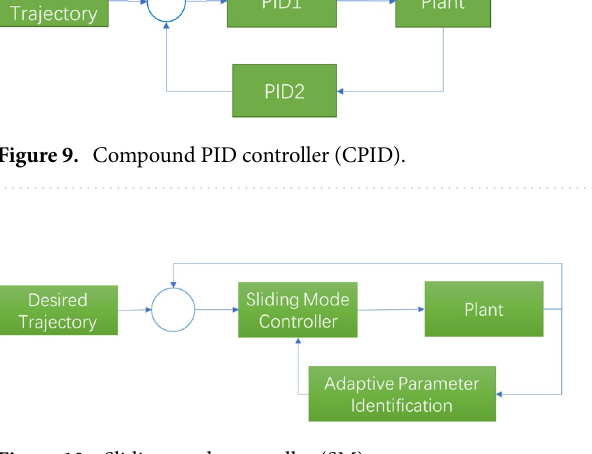
Figure 10. Sliding mode controller (SM).